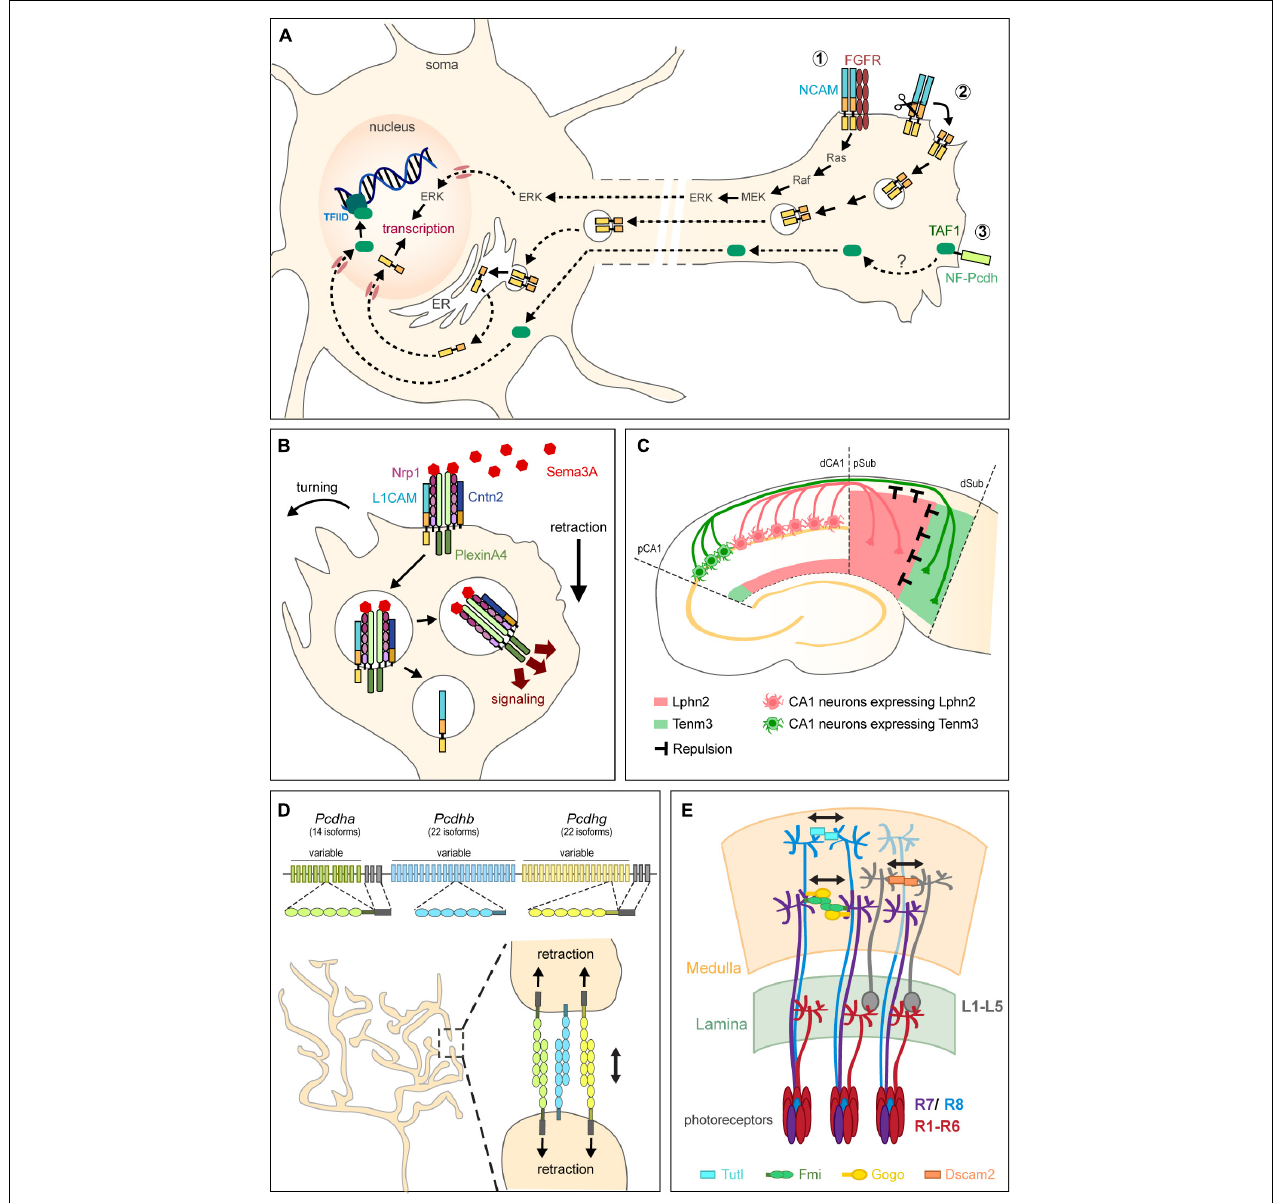
FIGURE 3 | Non-adhesive functions of CAMs in circuit assembly. (A) CAMs regulate transcription for axon growth by activating intracellular signaling pathways from the plasma membrane (1), acting directly in the nucleus after proteolytic cleavage (2), or regulating the transport of molecules with transcriptional activity (3). NCAM, for instance, interacts with FGFR to activate the MAPK pathway and in turn, transcription (1). Alternatively, proteolytic processing of NCAM releases a fragment that is trafficked through endosomes and the endoplasmic reticulum (ER), released in the cytoplasm, and finally translocated into the nucleus where it regulates transcription (2). NF-protocadherin (NF-Pcdh) directly interacts with TAF1, a component of the basal transcription factor complex TFIID, suggesting that NF-Pcdh might regulate axon elongation through TAF1-mediated transcriptional control. (B) CAMs instruct axon repulsion by modulating signaling pathways. Both L1CAM and Cntn2 form a complex with Nrp1, the receptor to the repulsive guidance cue Sema3A, at the plasma membrane. Cntn2 modulates axon response to Sema3A by regulating the endocytosis of the Nrp1/L1CAM/Sema3A complex. After internalization, L1CAM and Nrp1 become segregated by Cntn2 into two distinct trafficking pathways. Nrp1 is routed to endocytic compartments where its increased association with PlexinA4 signals for collapse. Adapted from Law et al. (2008) and Dang et al. (2012). (C) CAMs instruct repulsion by acting as guidance cues. In the hippocampus, reciprocal repulsions mediated by Tenm3 and Lphn2 ensure proper target selection. Axons originating from proximal CA1 (pCA1) neurons (green) express Tenm3 and project to the distal subiculum (dSub) after being repelled by Lphn2 (pink) present in the proximal subiculum (pSub). Conversely, distal CA1 (dCA1) axons expressing Lphn2 (pink) are repelled by Tenm3 in dSub (green) and project to pSub. Adapted from Pederick et al. (2021). (D) Clustered Pcdhs regulate self-avoidance. Pcdh genes are organized into three adjacent clusters that include several variable exons. Each variable exon codes for an extracellular and transmembrane domains and is preceded by a promoter randomly activated in individual neurons to drive transcription. Stochastic promoter choice leads to the production of different Pcdh isoforms from each of the three clusters in a